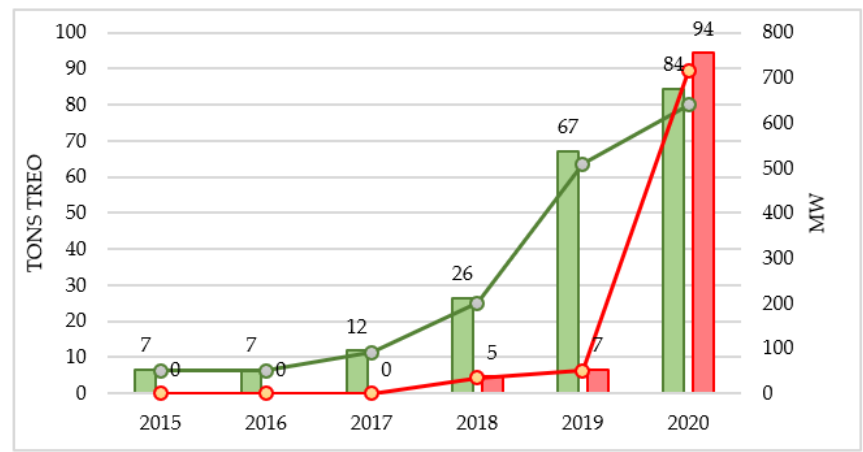
Figure 7. Comparison of planned and actual indicators of wind production capacities in Russia with an assessment of potential requirements for rare-earth materials.